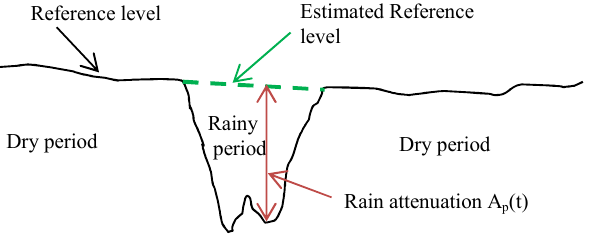
Fig. 6. Received signal during a rain event.